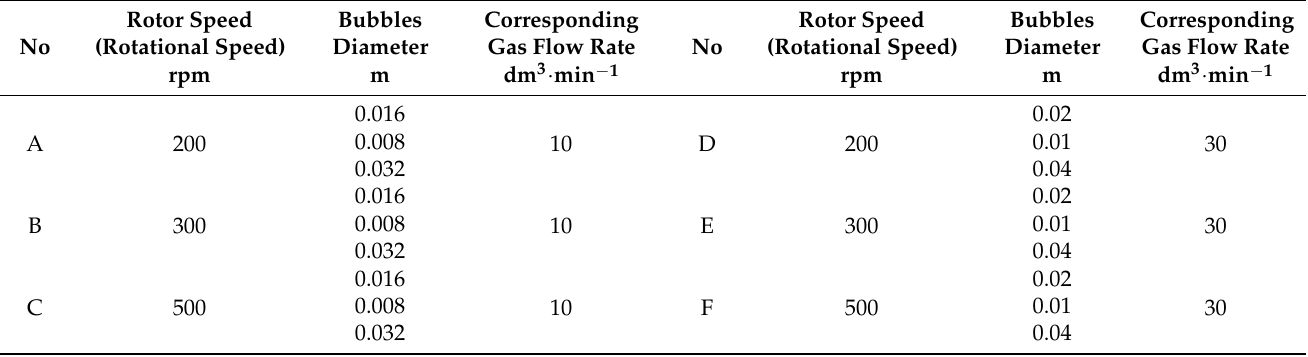
Table 2. Data assumed for